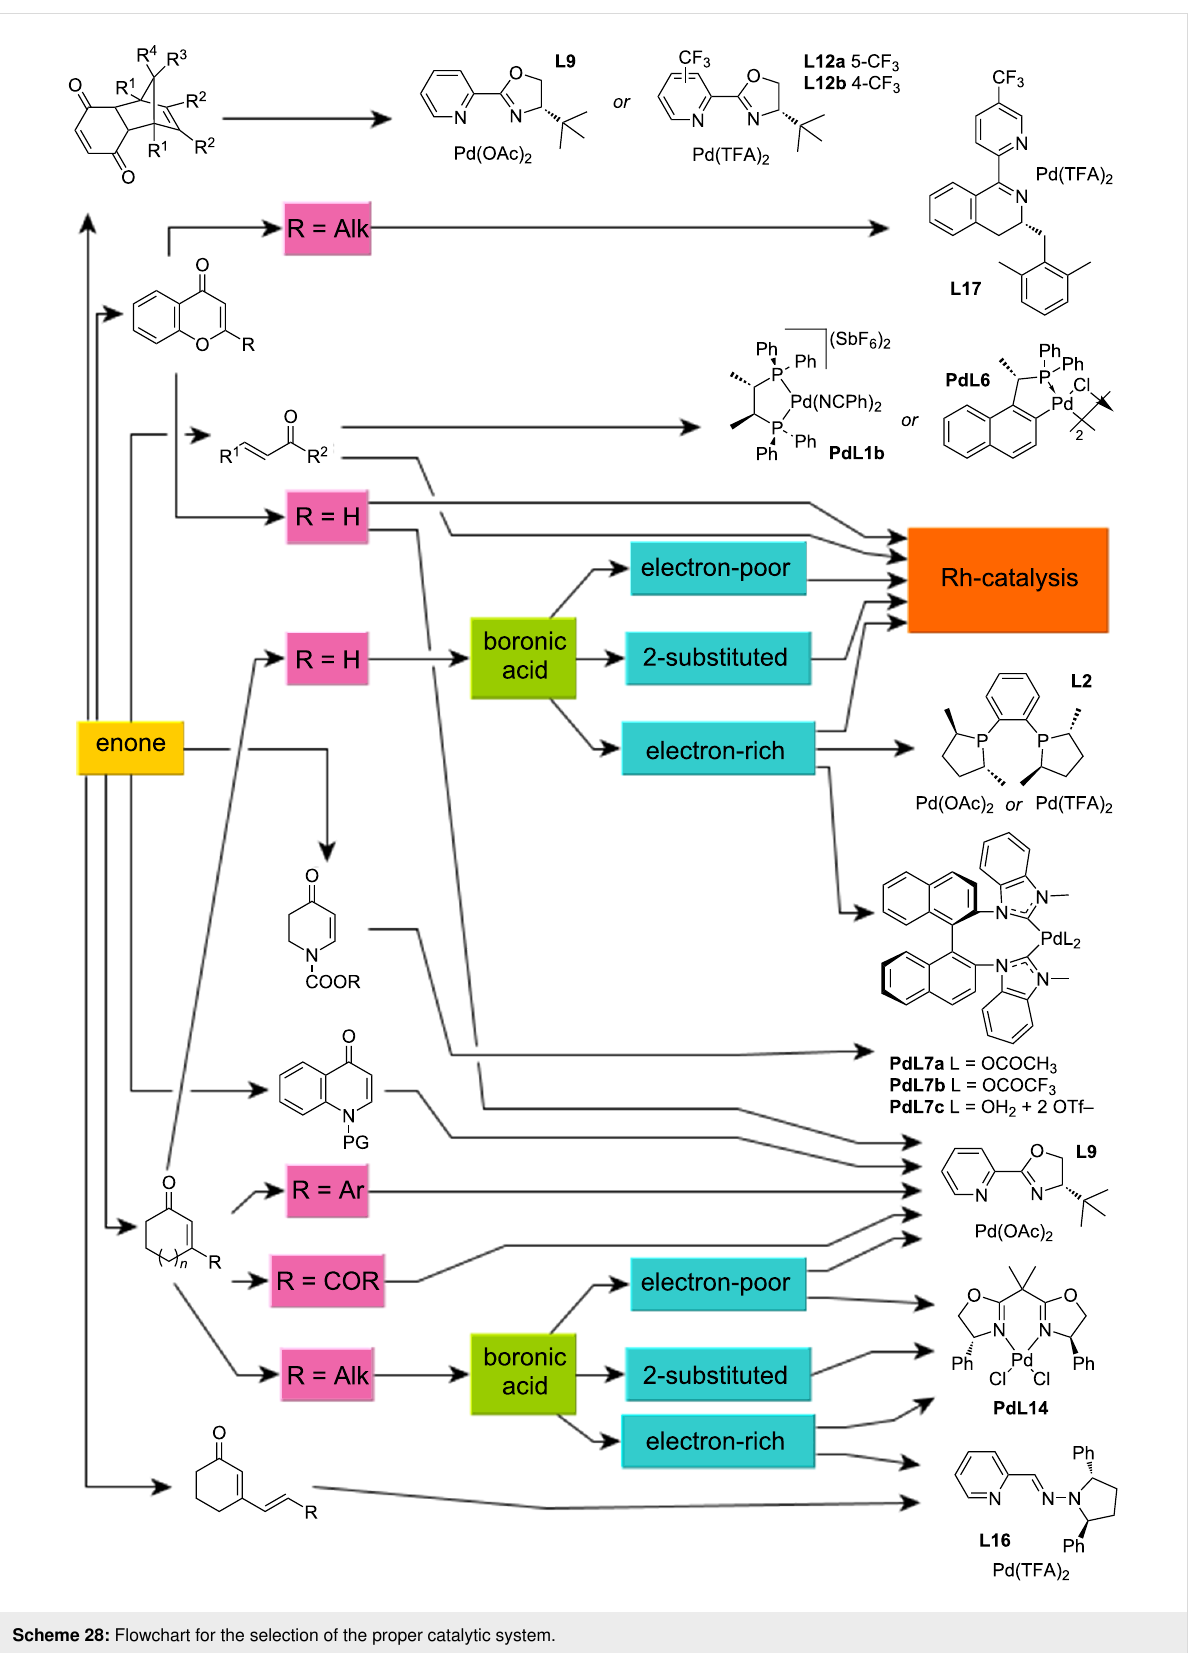
Scheme 28: Flowchart for the selection of the proper catalytic